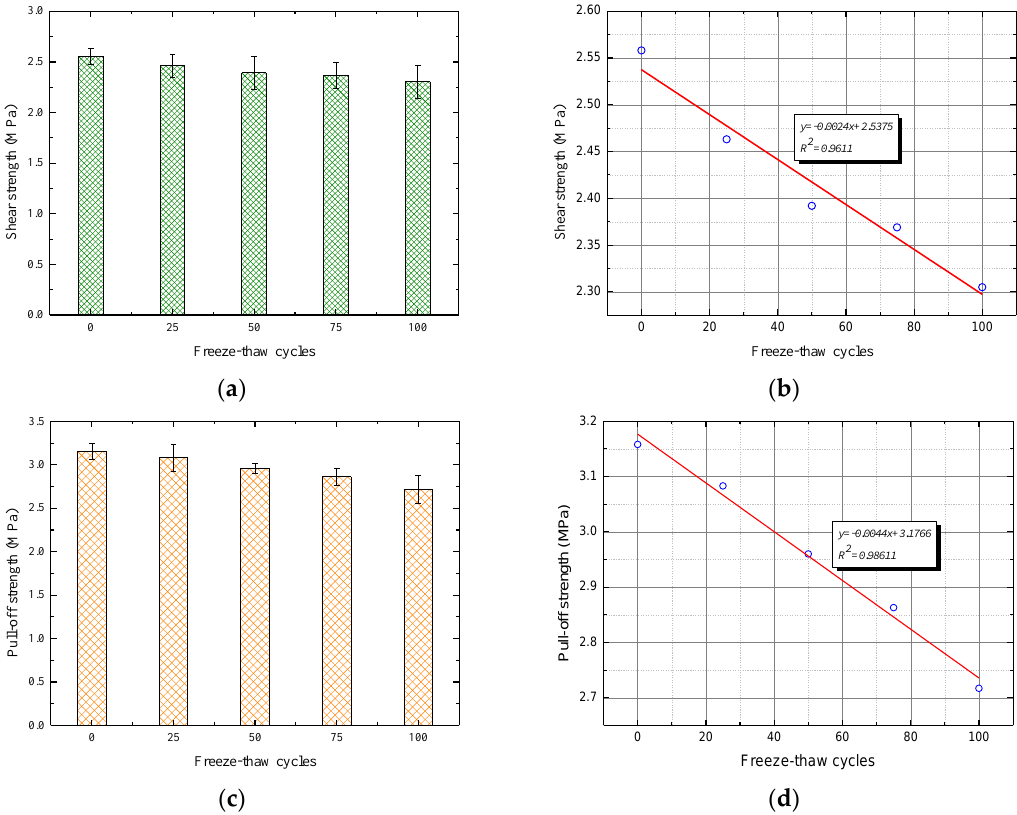
Figure 10. Effect of freeze-thaw cycles on strength: ( a ) Changes in shear strength, ( b ) fitting of shear strength and freeze-thaw cycles, ( c ) changes in pull-off strength, and ( d ) fitting of pull-off strength and freeze-thaw cycles.